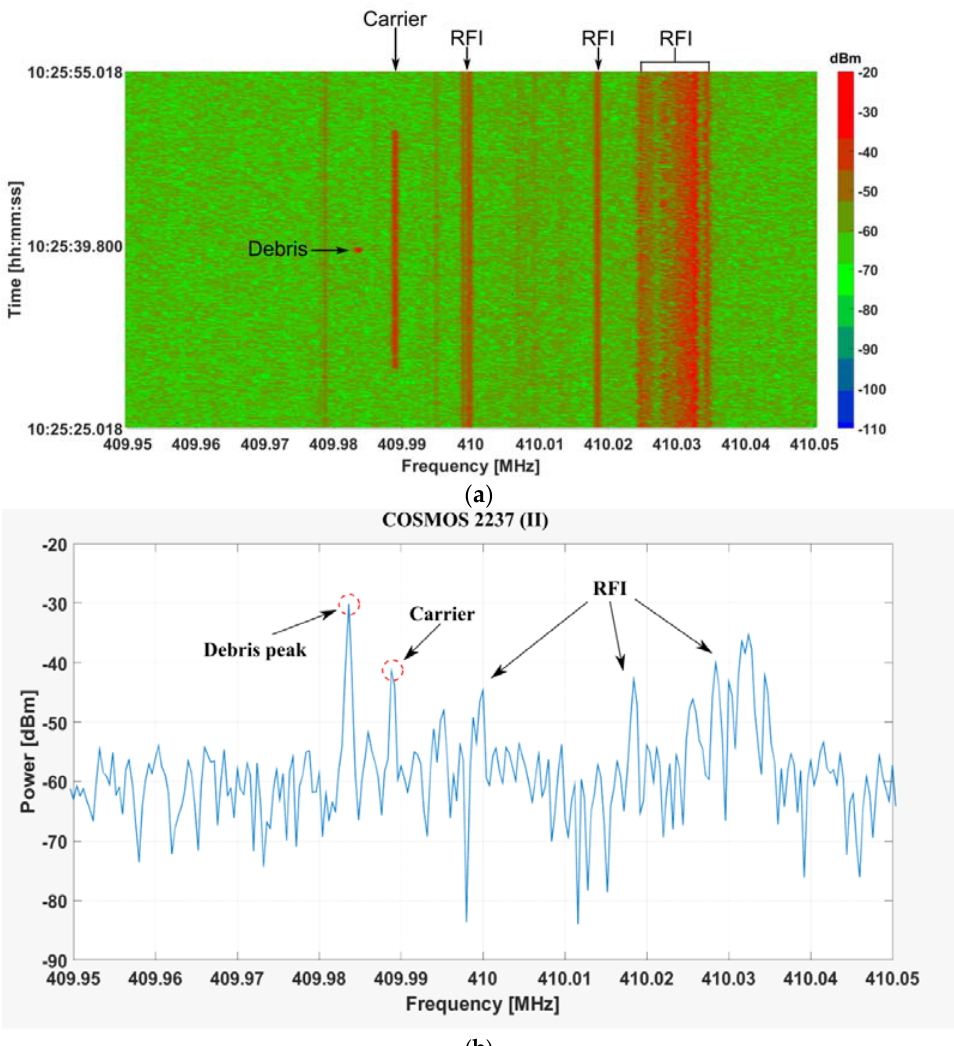
Figure 4. COSMOS 2237 (second passage): ( a ) spectrogram; ( b ) screenshot of the spectrum analyzer at the center of the visibility interval (Table 4).